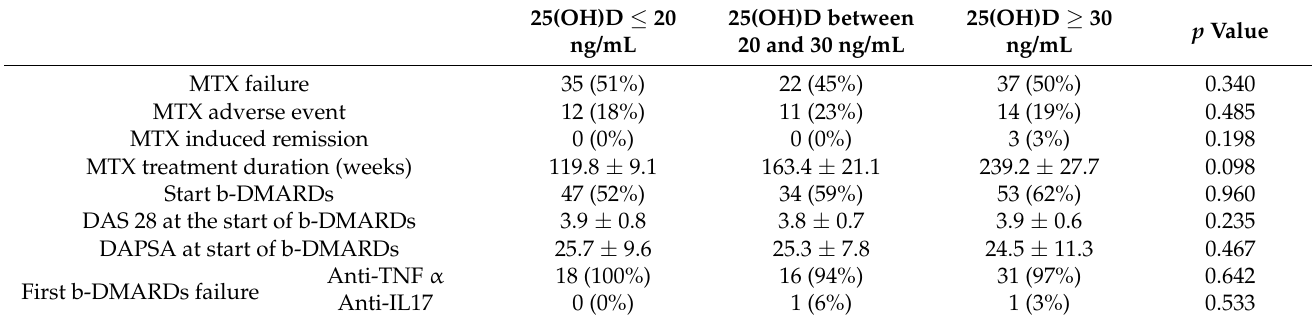
Table 2. Comparison of therapies at follow-up visits between PsA patients with different sta- tuses of 25(OH)D serum level: 25(OH)D ≤ 20 ng/mL vs. 25(OH)D between 20 and 30 ng/mL